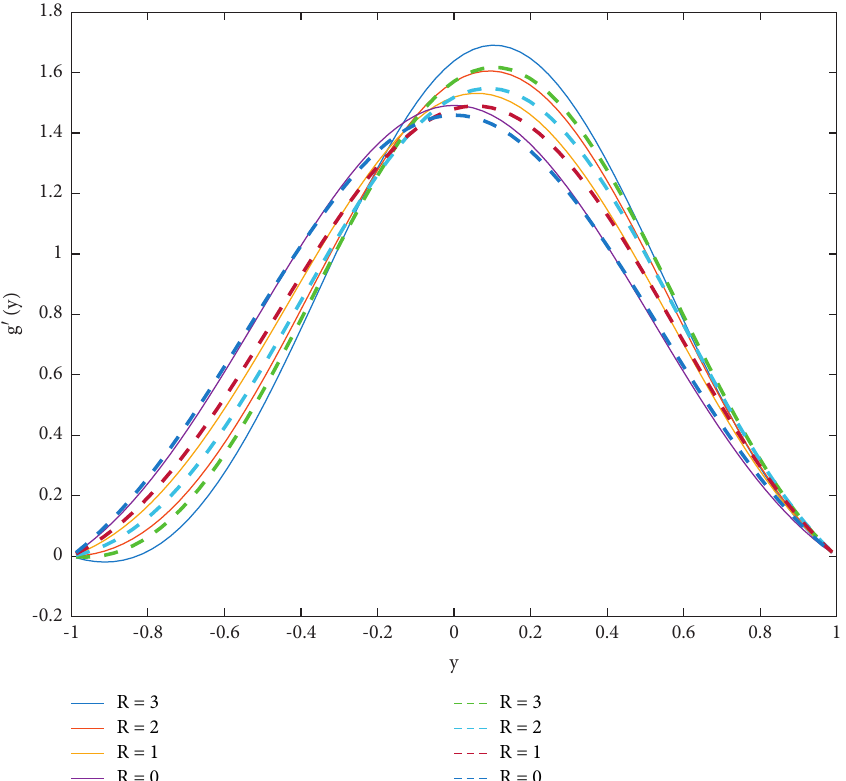
Figure 9: Impact of R over the profile g ( 1 ) ( y ) for SWCNTs (concrete lines) and MWCNTs (dashed lines) via S2HWs for the parameters A ∗ � 0 . 2 , φ � 0 . 1 , α �